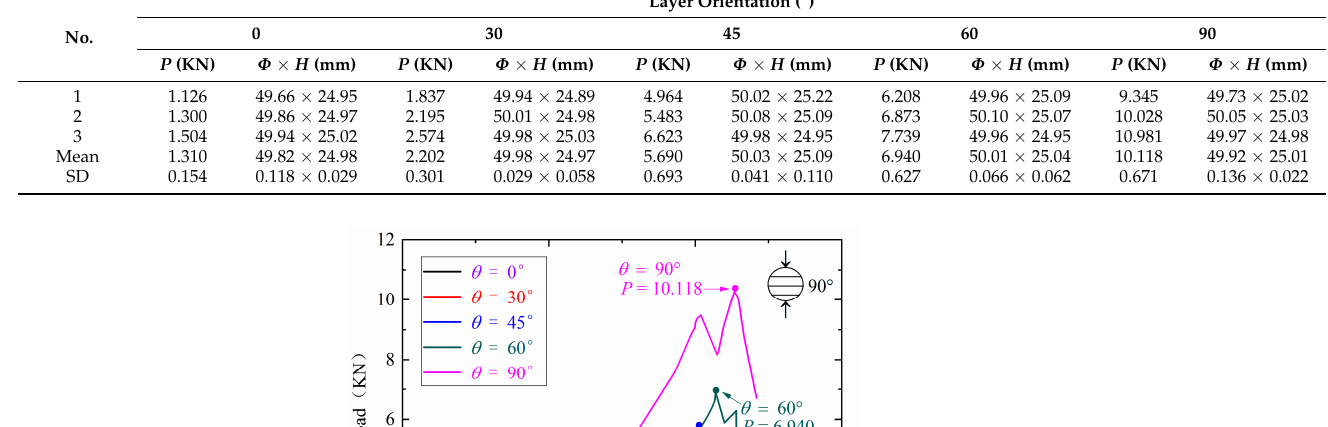
Figure 4. Peak load-displacement curves of continental shale with different layer orientations. Table 1. Statistical table of Brazilian test data of continental shale.